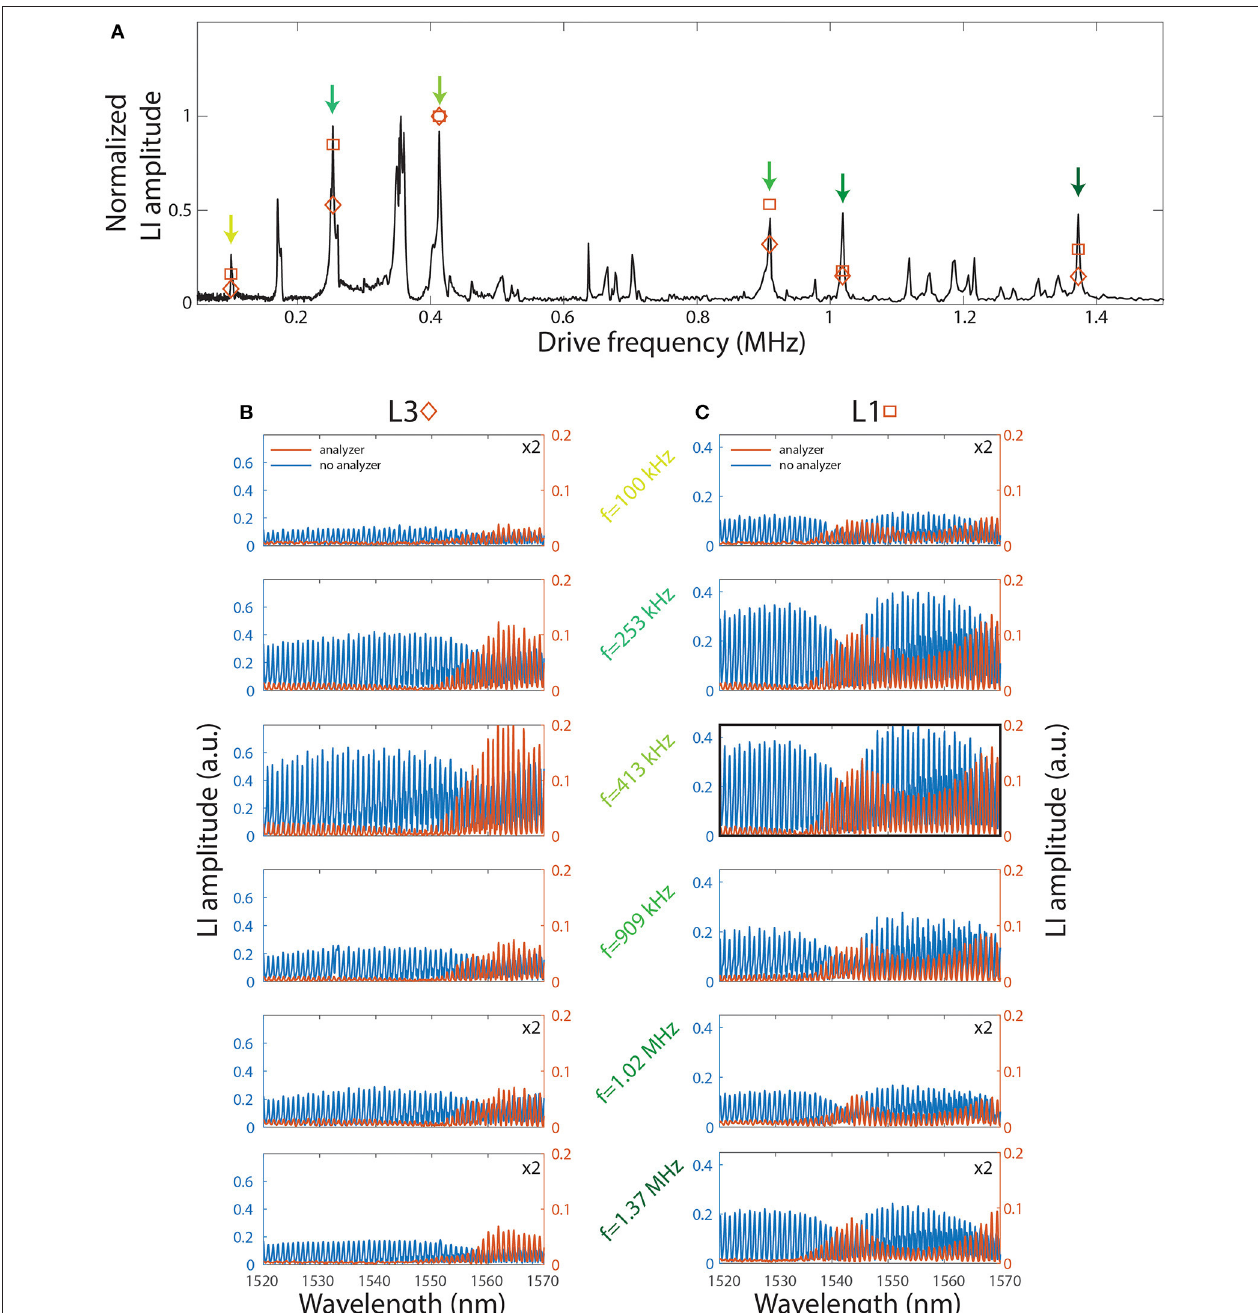
FIGURE 7 | (A) Broadband mechanical spectrum. LIA-demodulated spectra for several driving frequencies are reported for sample L3 (B) and L1 (C) .